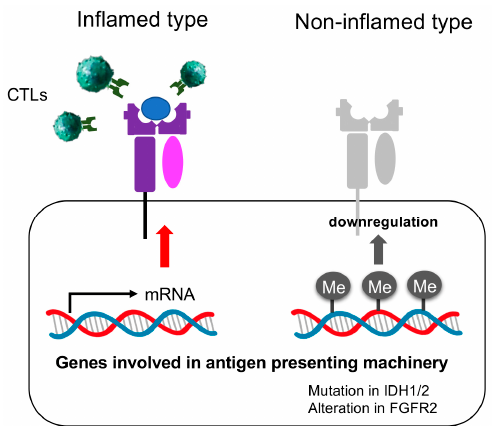
Figure 5. Schematic representation of the role of methylation and downregulation of genes involved in antigen presentation. In cholangiocarcinomas (CCAs), the phenotype of “inflamed” and “non- inflamed” classes, determined by the transcriptome of tumor-infiltrated lymphocytes, is strongly associated with the methylation and downregulation of genes related to antigen-presenting machinery. Consequently, lack of antigen-presenting machinery for the presentation of tumor-specific neoantigen result in the failure of attracting cytotoxic T lymphocytes (CTLs) into tumor. Some driver mutations unique to CCAs, such as mutations in the IDH1 / 2 genes and alterations in the FGFR2 gene, may be associated with these methylation and downregulation events .